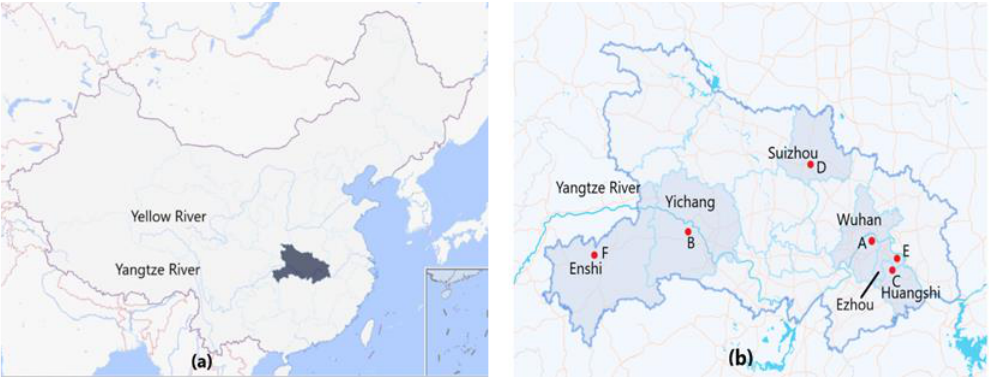
Figure 4. ( a ) Location of Hubei Province and ( b ) community location distribution.